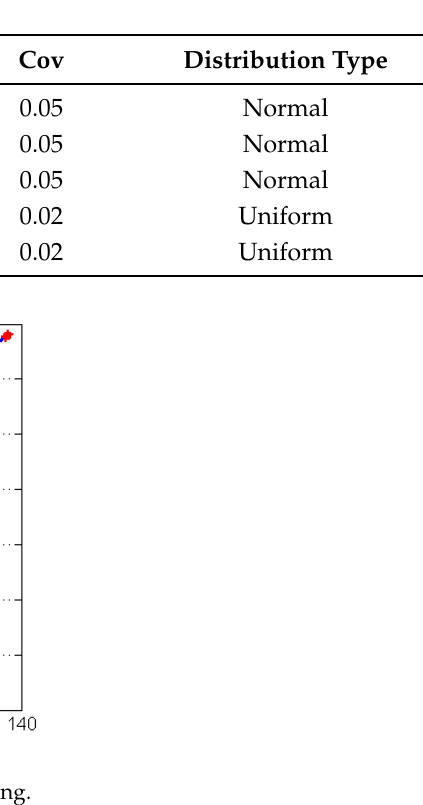
Figure 12. Cross-validation results for SPL using Kriging. After the validation of the Kriging surrogate model, a sampling set with the number of N = 10 6 for uncertain parameters (Table 5) is generated, then the MCS is performed using the Kriging approximation Figure 13.